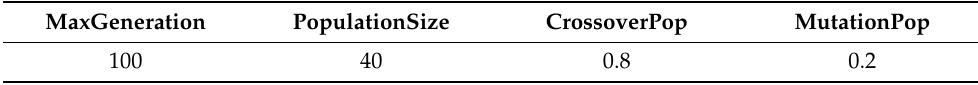
Table 1. Parameter values for